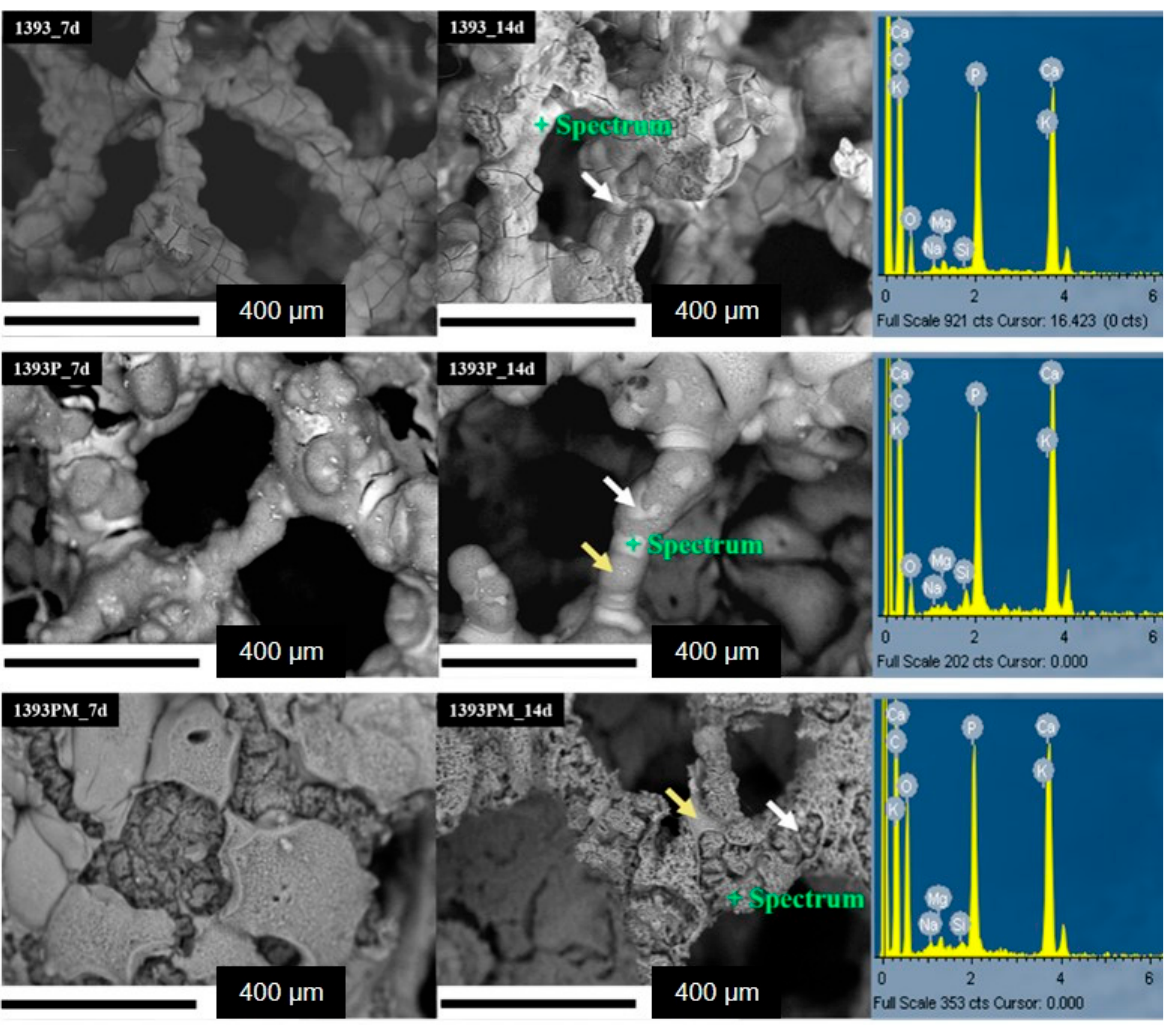
Figure 11. SEM micrographs of backscattered electrons of all scaffolds immersed in SBF for 7 and 14 days and representative EDS spectra of all samples after 14 days of immersion.